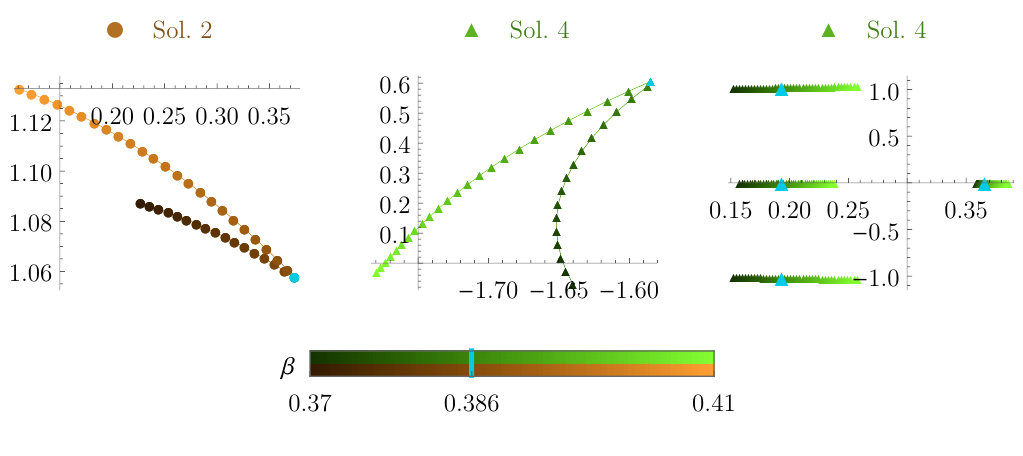
Figure 4 . A magni(cid:12)ed plot of the overlaps of solution 2 and 4 at a joint kink around (cid:12) (cid:25) : 386. The kinks are due to the sudden jump in the S -matrices corresponding to a rapidity di(cid:11)erence close to (cid:0) i, as is the case for the highlighted Bethe root solution to the right.